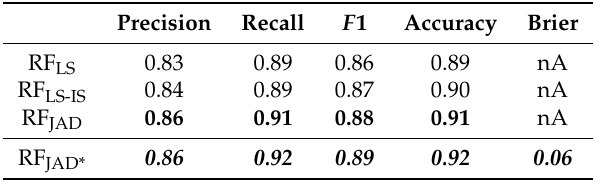
Table 2. Binary classification performance of different RF models averaged over an 8-fold cross-validation. The Brier score was only determined for the fine-tuned JAD* model. Precision Recall F